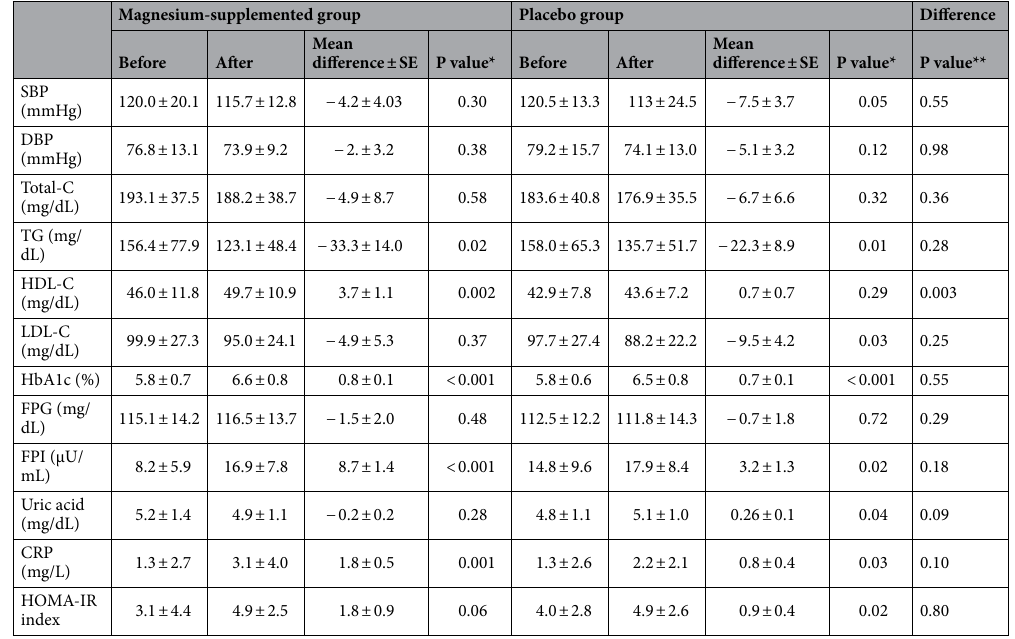
Table 3. Cardiometabolic markers of participants before and after intervention. SBP systolic blood pressure, DBP diastolic blood pressure, C cholesterol, TG triglyceride, FPG fasting plasma glucose, fasting plasma insulin, CRP C-reactive protein. *Resulted from paired t-test for comparing mean values of outcomes before and after intervention in each study group. **Resulted from ANCOVA for comparing two study groups based on mean values of outcomes after intervention and adjustment for baseline